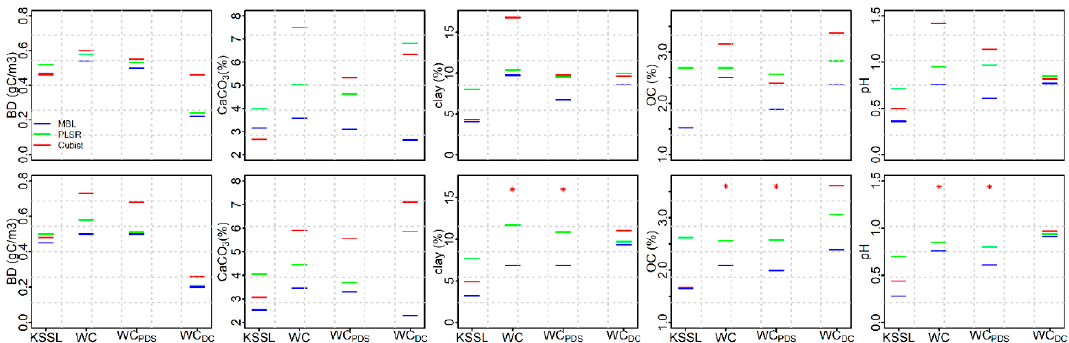
Figure 2. Root mean square error (RMSE) of KSSL, Woodwell (WC), Woodwell PDS (WC PDS ) and Woodwell DC (WC DC ) spectra representing transfer set (set I) for all three modeling approaches (memory-based learning (MBL), partial least squares regression (PLSR) and Cubist). The top and bottom panel shows the RMSE estimated using the prediction from the baseline corrected and first derivative spectra, respectively. The Woodwell DC are the Woodwell spectra predicted using the direct calibration and leave-one-out cross validation. The red asterisk symbol shows that the RMSE using Cubist are too high to be included within the y -axis range for the given soil property.